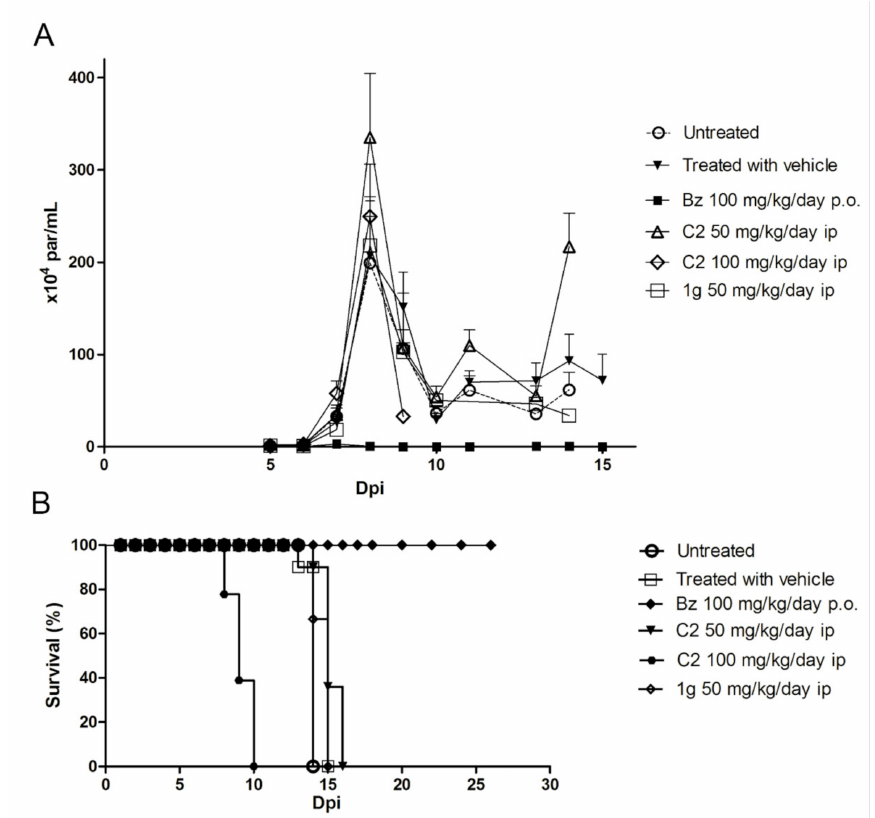
Figure 3. Effect of 1,4-naphthoquinone derivatives (C2 and 1g ) in acute murine model of T. cruzi infection. Parasitemia levels ( A ) and survival rate ( B ) of mice intraperitoneally infected with T. cruzi trypomastigote forms (Y strain) and submitted to different treatment regimens ( n = 5